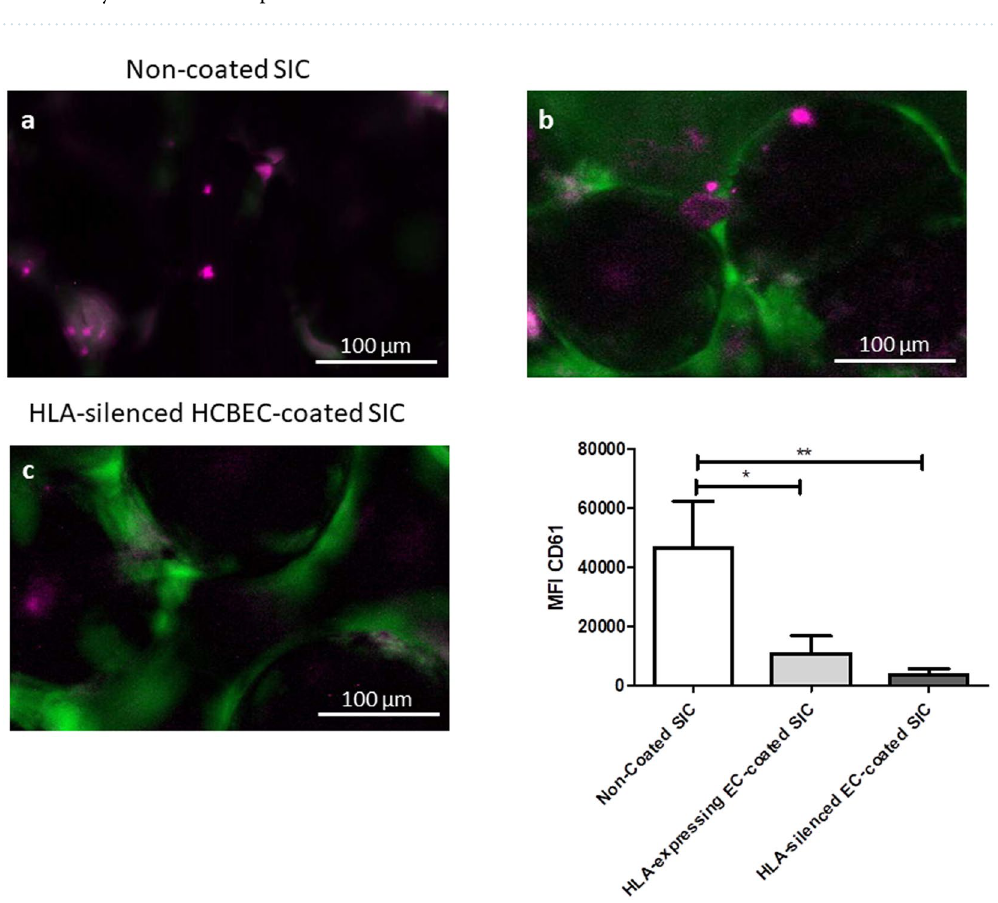
Figure 5. Lower thrombogenicity of endothelialized SIC compared to native SIC. Native or endothelialized SIC with HLA class I-expressing or silenced ECs were exposed to platelets, which were activated with ADP and thrombin for 1 h. Platelets were labeled with Allophycoyanin conjugated anti-CD61 antibody (magenta) and ECs expressed GFP as reporter gene (green). Thrombus formation was analyzed by fluorescence microscopy, indicating that ( a ) native SIC was more thrombogenic than ( b ) SIC endothelialized with HLA class I-expressing ECs or ( c ) SIC endothelialized with HLA class I-silenced ECs. ( d ) Mean fluorescence intensities are depicted in the bar graph. The paired two-tailed t-test was used to determine statistically significant differences (p < 0.05) indicated by the asterisks ( * ). The results are expressed as mean ± standard deviation (n =